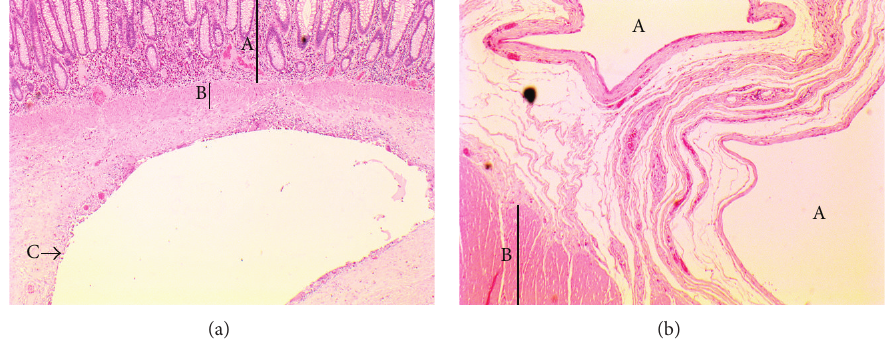
Figure 3: Microscopic appearances of the resected recto-sigmoid colon showing pneumatosis coli. Multiple cyst-like spaces situated predominantly in the submucosa lined by endothelial cells, macrophages, and multinucleate giant cells. Patchy chronic inflammatory cell infiltrate rich in eosinophils in the surrounding stroma. The mucosal layer showed focal hyperplastic changes and patchy nonspecific chronic active inflammation. There was no dysplasia or malignancy. (a) (A) Mucosa, (B) muscularis mucosae, and (C) air-filled space within submucosa. (b) (A) Air-filled spaces, (B) muscularis